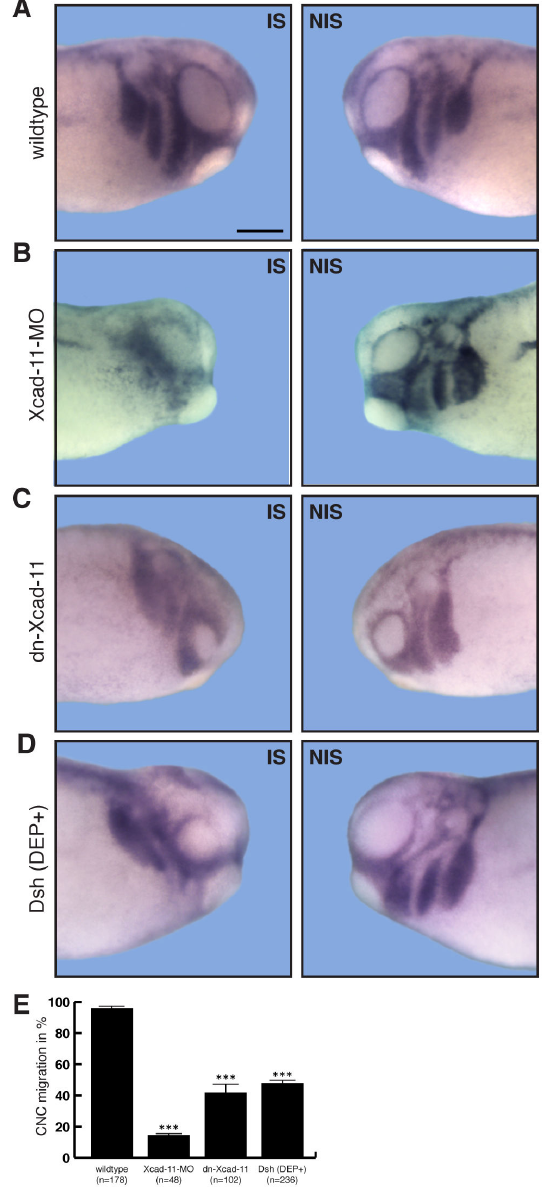
Figure 1. Depletion of Xcad-11 adhesive function blocks CNC migration in vivo . Lateral view of Xenopus CNC at stage 26, analysed by whole-mount ISH for the specific CNC marker AP-2α. Left column: Injected side (IS). Right column: Non-injected side (NIS). (A) Wildtype CNC cells migrated in defined streams into the pharyngeal pouches. (B) Xcad-11-MO injected embryos show AP-2α staining only at the dorsal part of the embryo, indicating incomplete CNC migration compared to NIS. (C) Overexpression of dn-Xcad-11 and (D) Dsh(DEP+) both showed incomplete and fused CNC hyoidal and branchial migration streams. Percentage of complete CNC migration given in (E) with n = number of embryos. Error bar shows standard error. (***) Significance to wildtype with p<0.005 after student’s T-Test. Scale bar, 250 µm. doi: